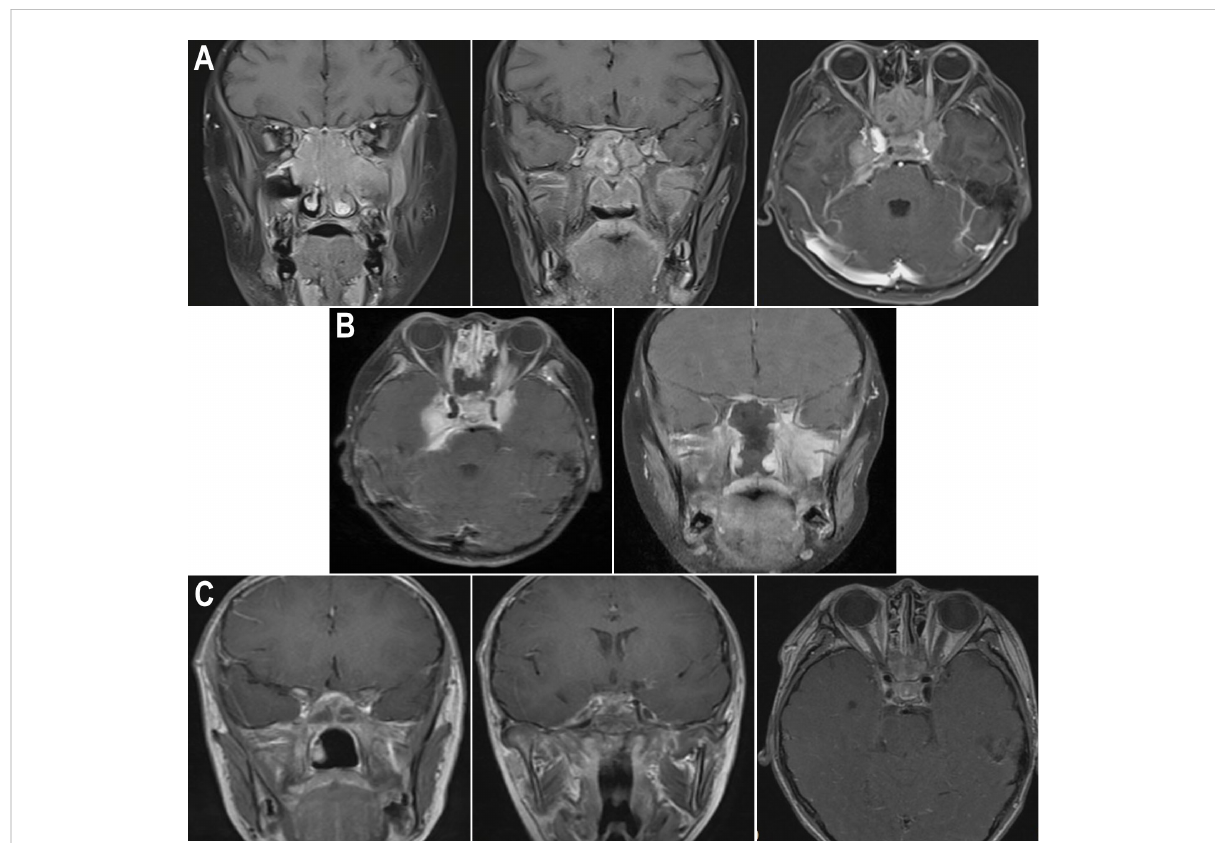
FIGURE 2 Enhanced nuclear MRI images of the patient during different periods. (A) Pre-op sagittal MRI images showed that the mass invaded the nasal cavity, ethmoid sinus, and sphenoid sinus, and compressed the optic nerve; pre-op axial MRI image revealed that the mass invaded the middle and posterior cranial fossa. (B) Post-op MRI images showed that intraoperative decompression of the optic nerve was performed. (C) Post-op MRI images showed the condition of the optic nerve and intracranial tumor after 1 month of